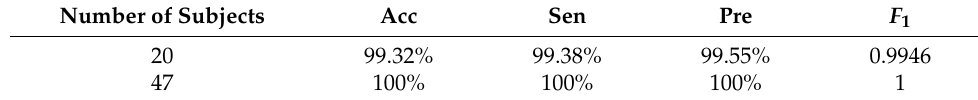
Table 7. Comparison of identification results for 20 and 47 subjects.